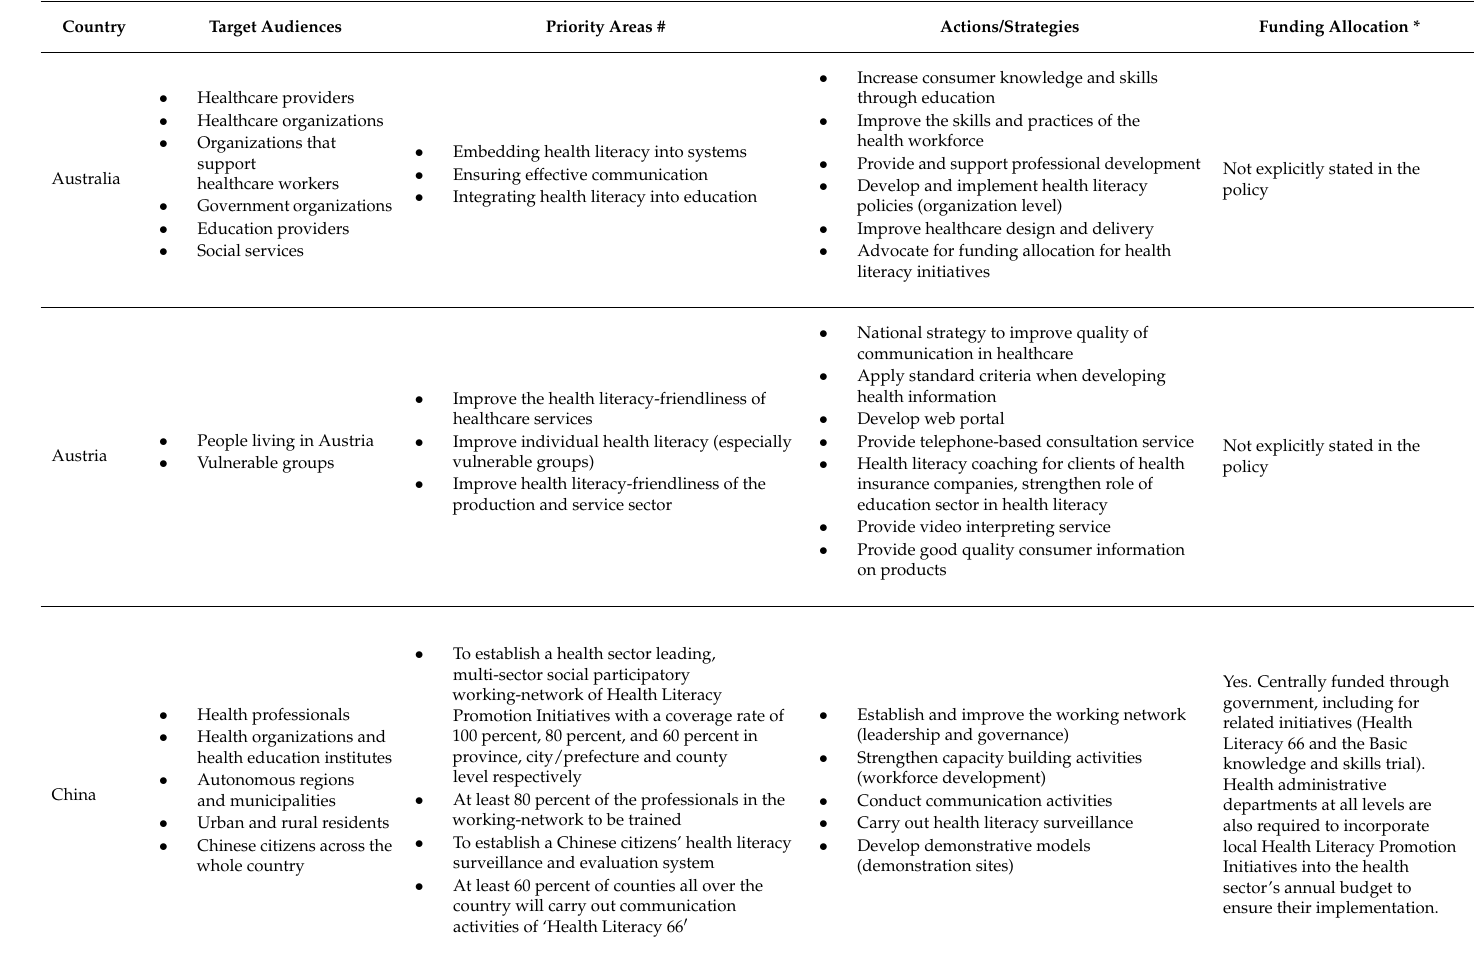
Table 2. Analysis of selected policy